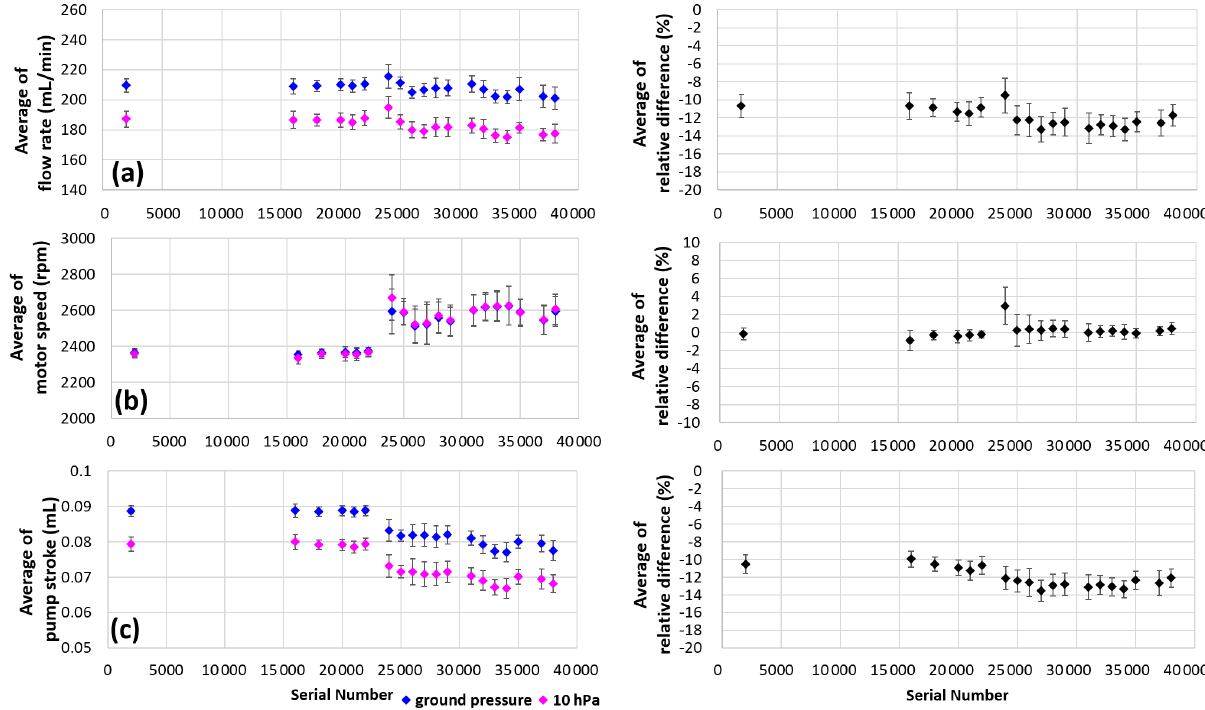
Figure 16. (a) Temporal variations in pump flow rate, (b) pump motor speed, and (c) pump stroke at ground pressure and 10hPa averaged for each serial number of ozone sensors from 2009 to 2022 (left: measurement averages; right: relative difference from values at ground pressure).